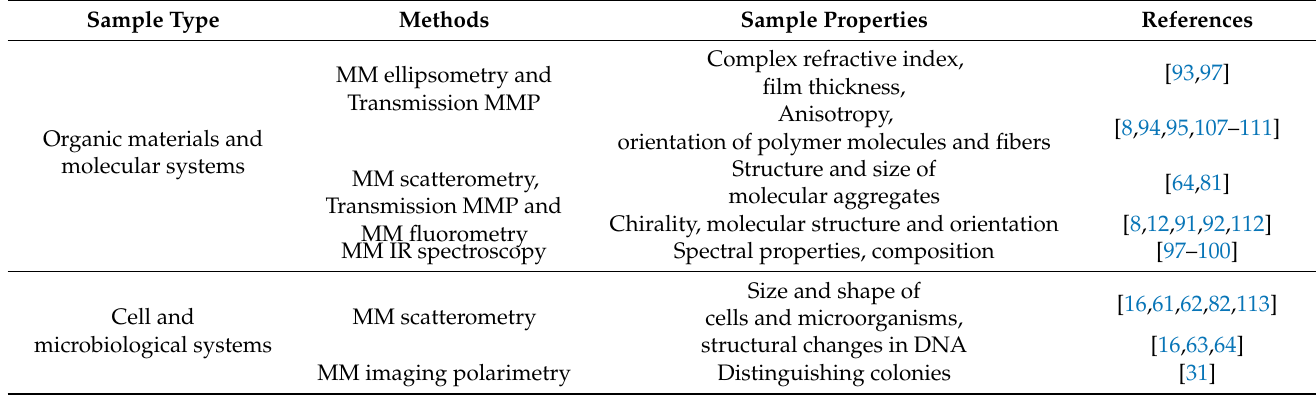
Table 1. Main types of biological and agricultural sample and MMP methods for their